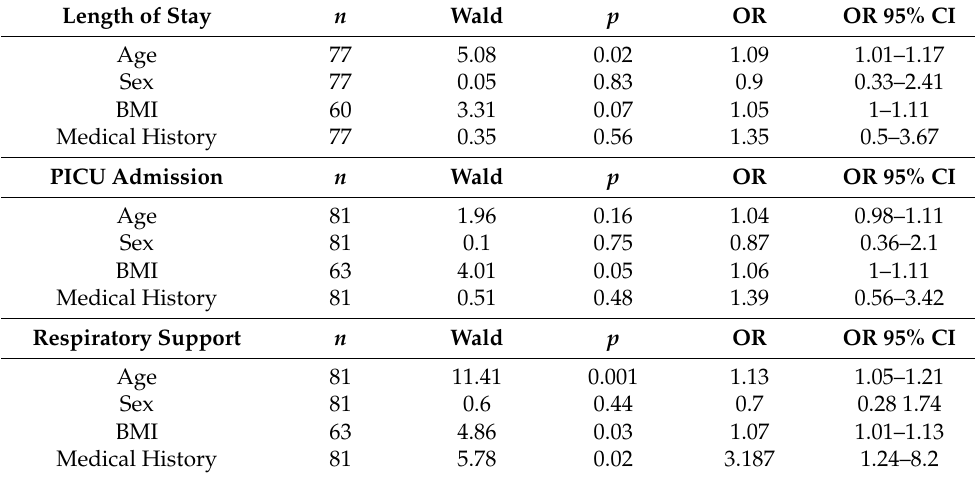
Table 2. Results from the logistic